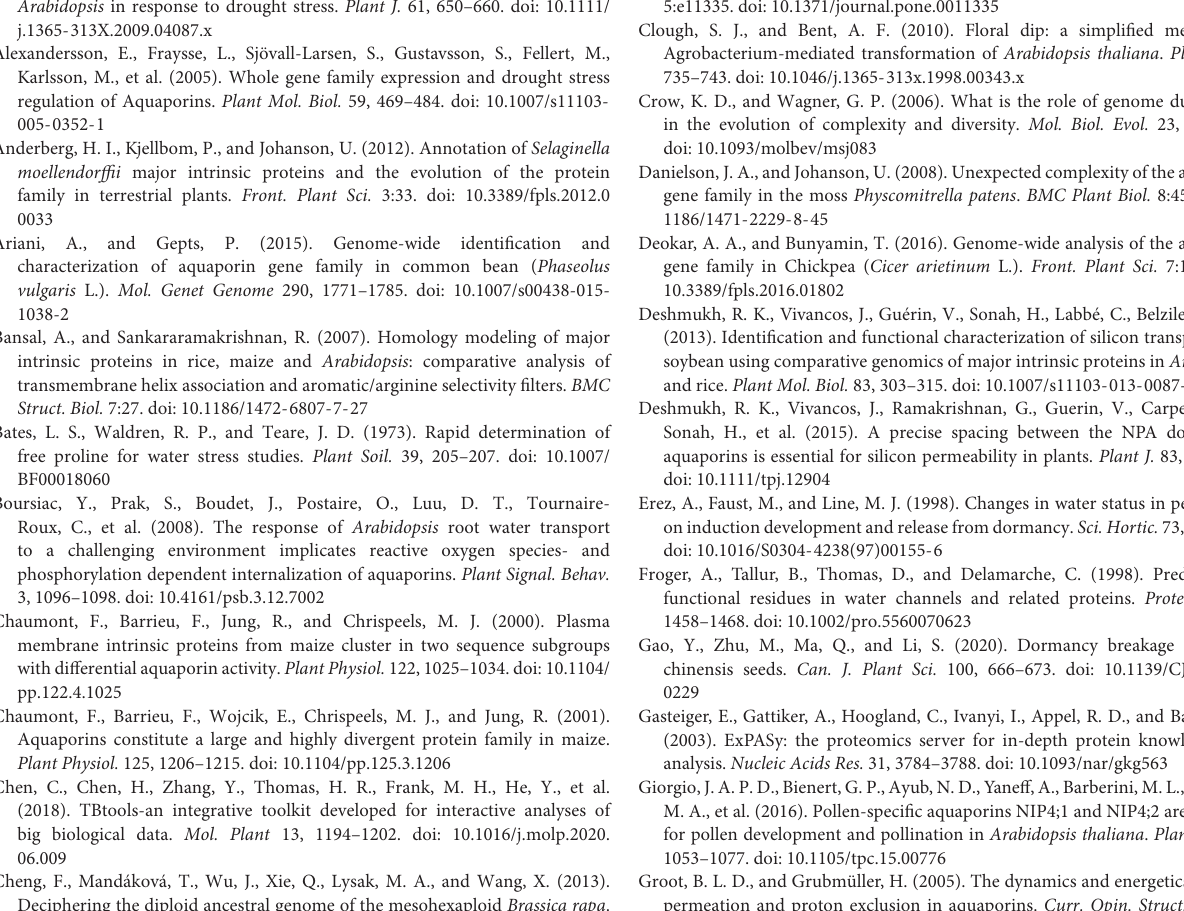
Supplementary Figure 6 | Protein sequence alignment of PaXIPs identified in P. armeniaca showing the amino acids at NPA domains, ar/R filters, and Froger’s residues. Supplementary Figure 7 | Distribution of conserved motifs in the PaAQP proteins. The motifs were identified via the online MEME program. The different colored boxes indicate different motifs at the corresponding positions. Supplementary Figure 8 | Various cis -acting elements in the promoter of PaAQP genes. The numbers of ARE (AAACCA), ABRE (ACGTG), MBS (CAACTG), MRE (AACCTAA), and other cis -acting elements in the promoter region of P. armeniaca PaAQP genes from each AQP family. The cis-acting elements were determined in